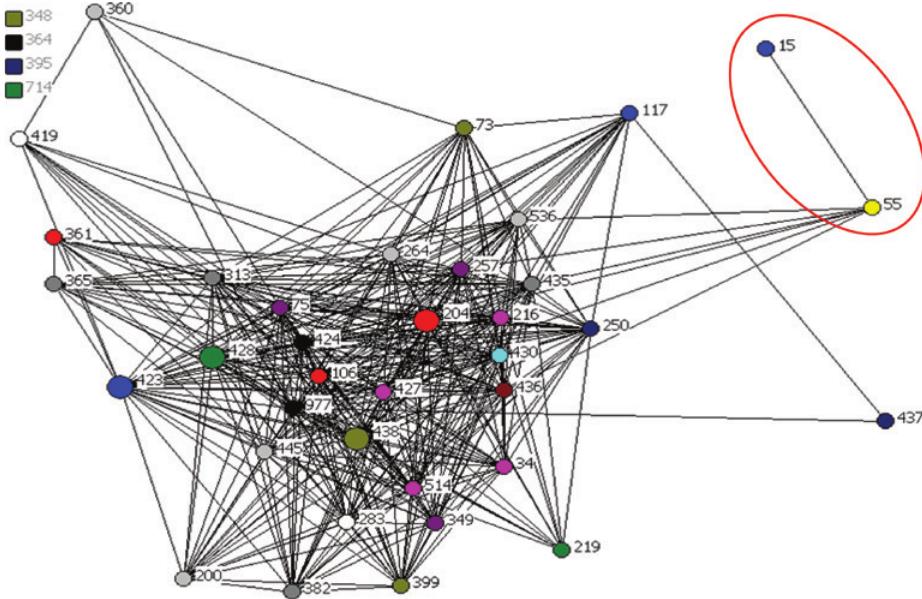
Figure 2: The classification number network in 1980 ~ 2000.